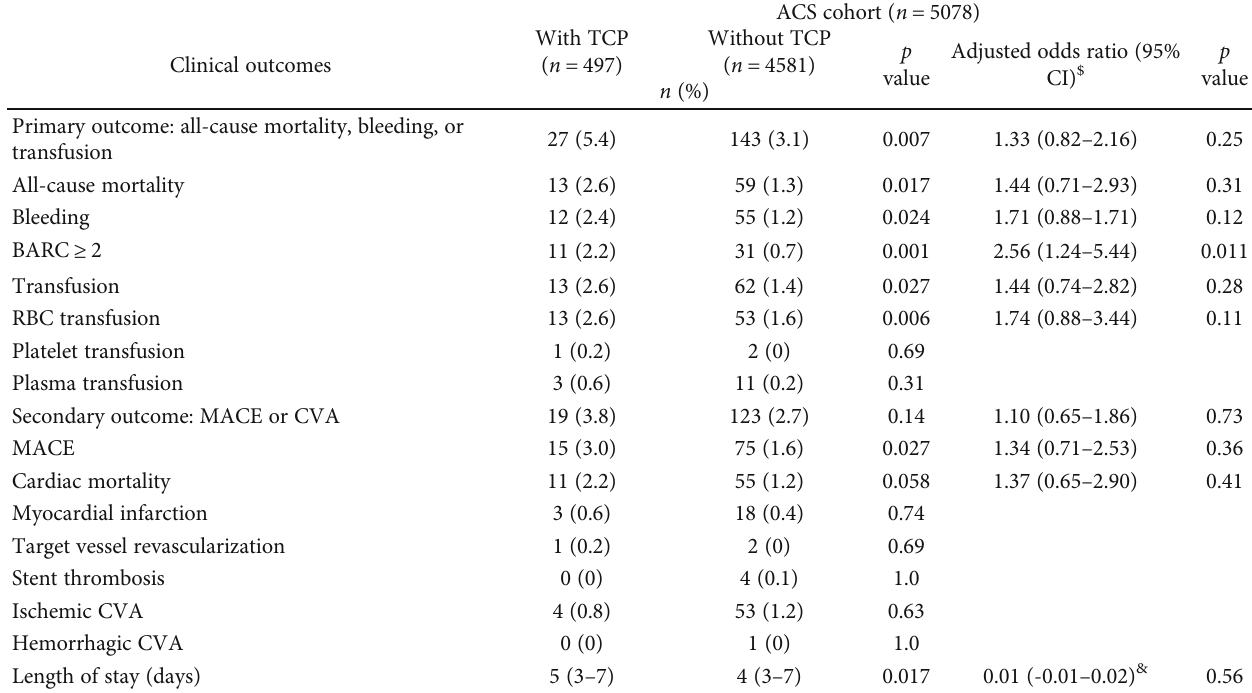
Table 4: The association between thrombocytopenia and the occurrence of in-hospital outcomes in the ACS cohort ( n = 5078 ).